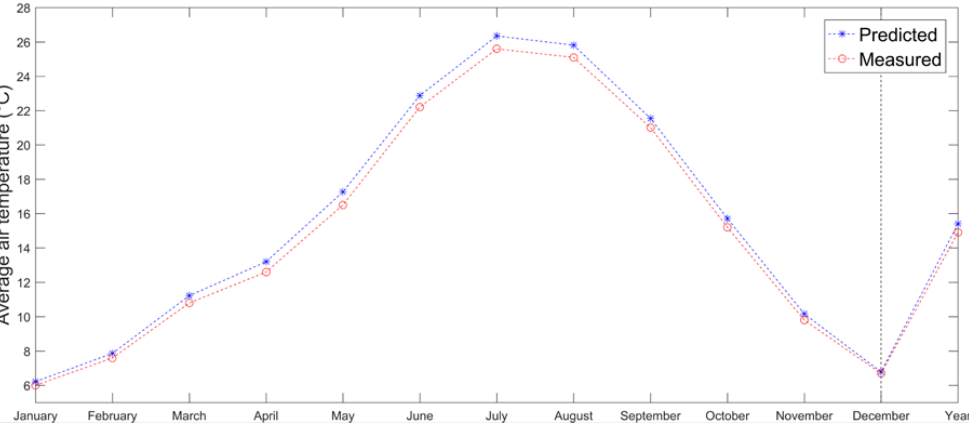
Figure 11. Estimated and measured monthly average air temperatures for Madrid (Spain) meteorological station using monthly lapse rates.